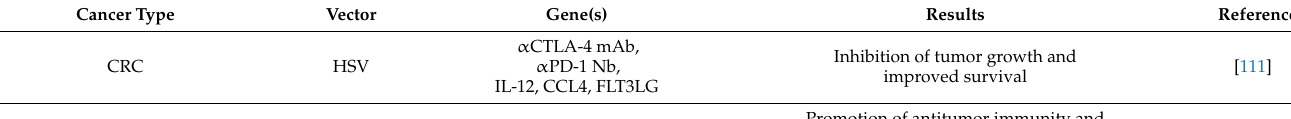
Table 1. Relevant preclinical studies based on ICI expression from gene therapy